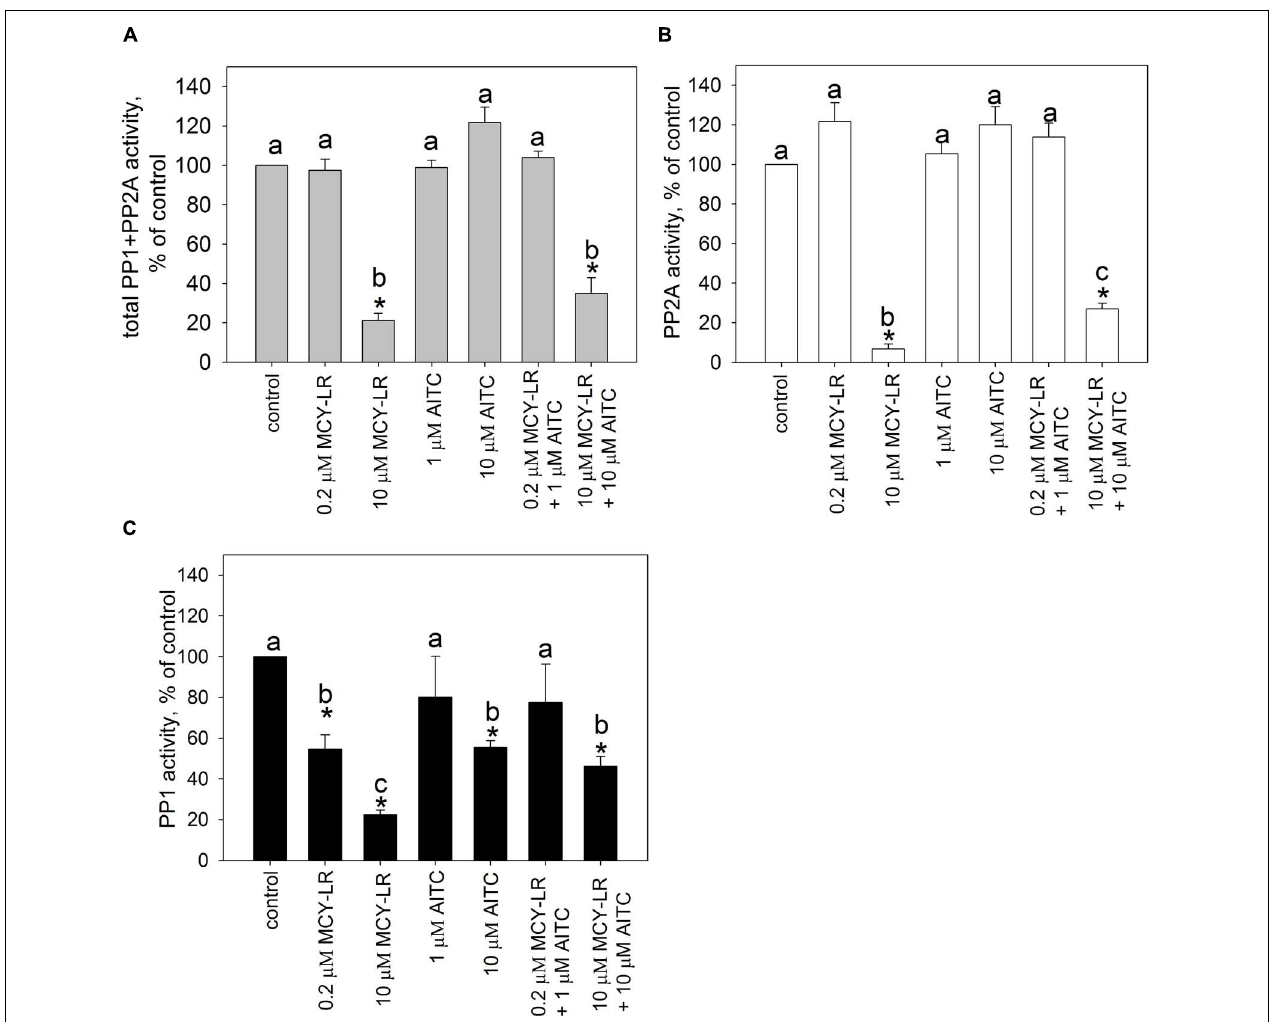
FIGURE 6 | Effects of AITC and MCY-LR on total protein phosphatase (PP1+PP2A) (A) , PP2A (B) , and PP1 (C) activities of V. faba tips of lateral roots in vivo . ∗ Significant differences of treatments to controls ( P < 0.05), n ≥ 6. All-pairwise multiple comparisons are indicated by letter